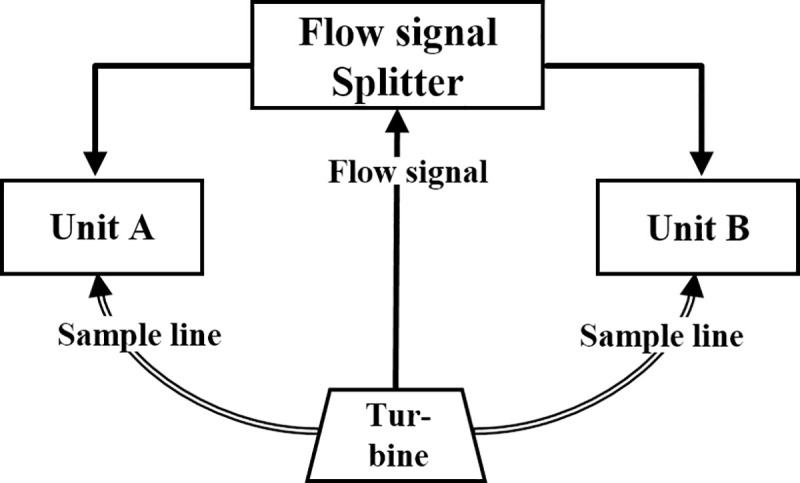
Test setup with simultaneous operation of two identical K5 units using a flow signal splitter.